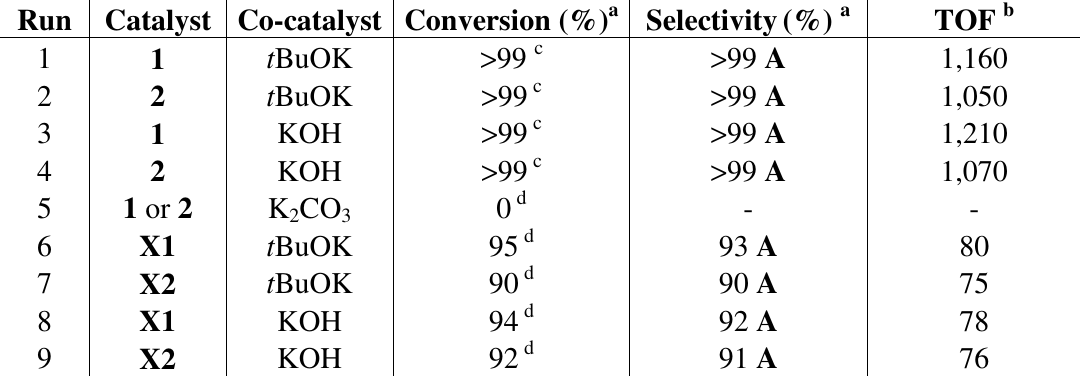
Table 2. Hydrogenation of trans -4-phenyl-3-butene-2-al by Ru(II)